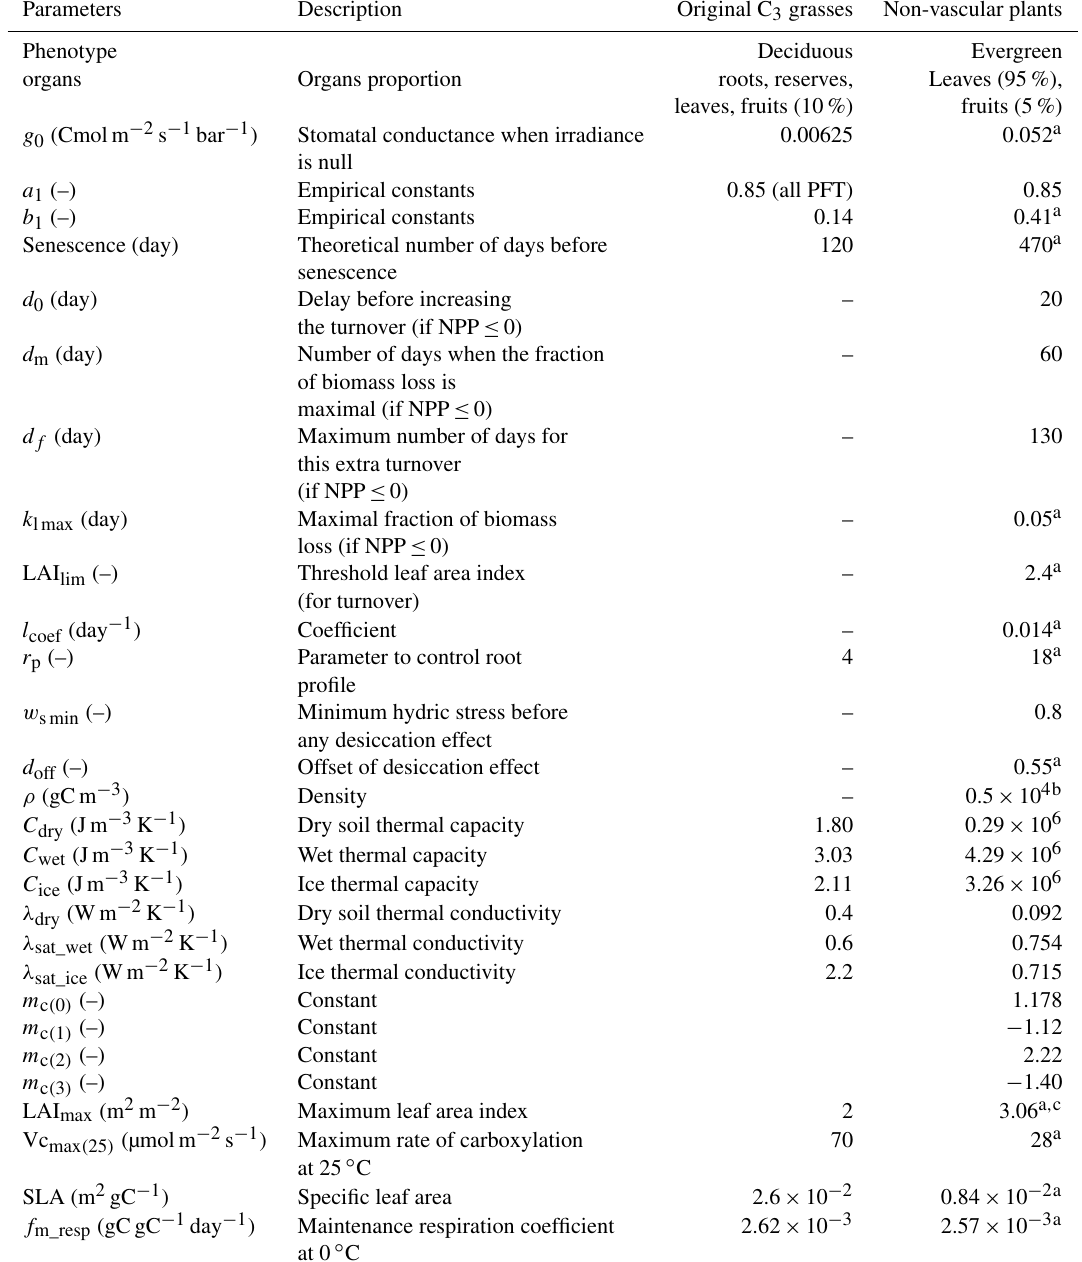
Table 2. Non-vascular plant